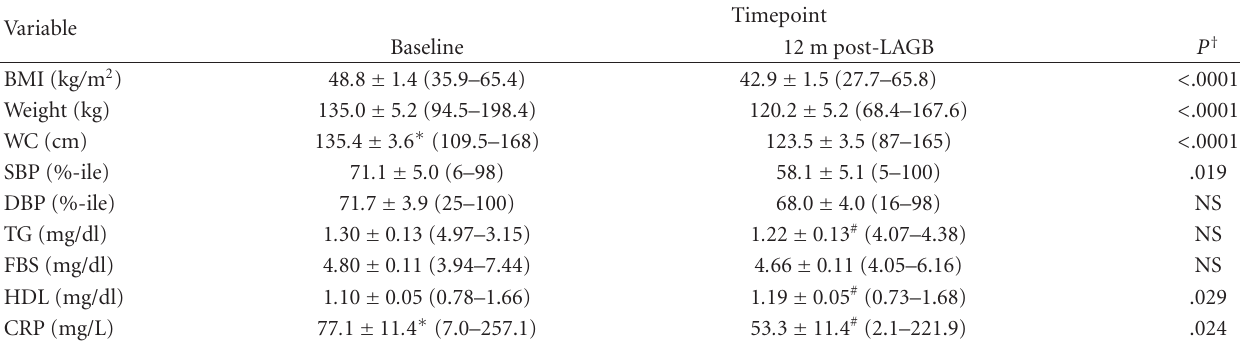
Table 3: Clinical characteristics and MeS variables at baseline and 12m post-LAGB ( N = 29).